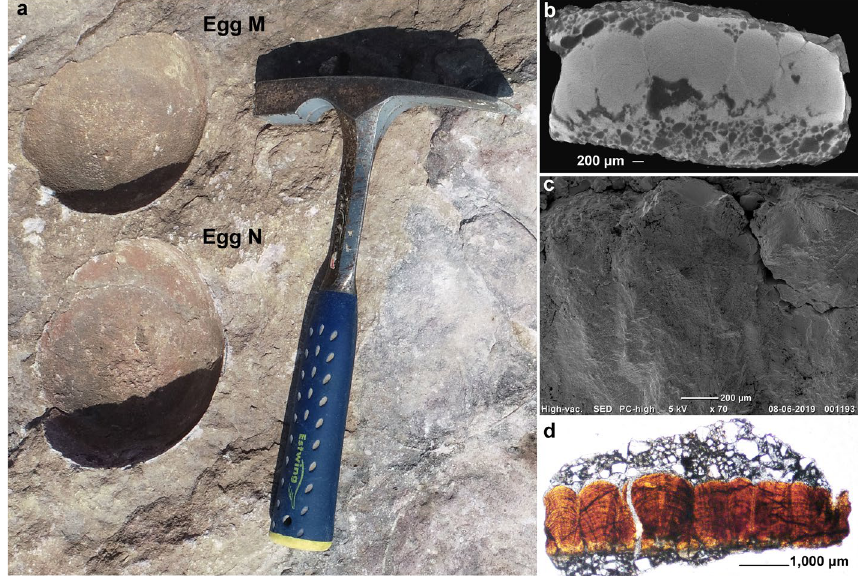
Figure 10. Field photograph and microscopic images of the eggshells from egg number M showing oospecies Fusioolithus baghensis characterized by fan-shaped shell units with arching growth lines and basal end cap units. ( a ) Egg numbers M and N present as sub-circular outlines. The eggs were excavated and eggshells were studied for parataxonomic classification. ( b ) X-Ray Microscopy photomicrograph of the eggshell showing fan-shaped shell units progressing upwards into bumpy nodes. Arching growth lines restricted to shell units can also be seen. ( c ) Radial SEM photograph showing curvy growth lines in the middle of the shell unit. ( d ) Radial thin section showing fan-shaped shell units merging with each other in the right segment where growth lines exist as sub-horizontal lines and partially preserved basal end